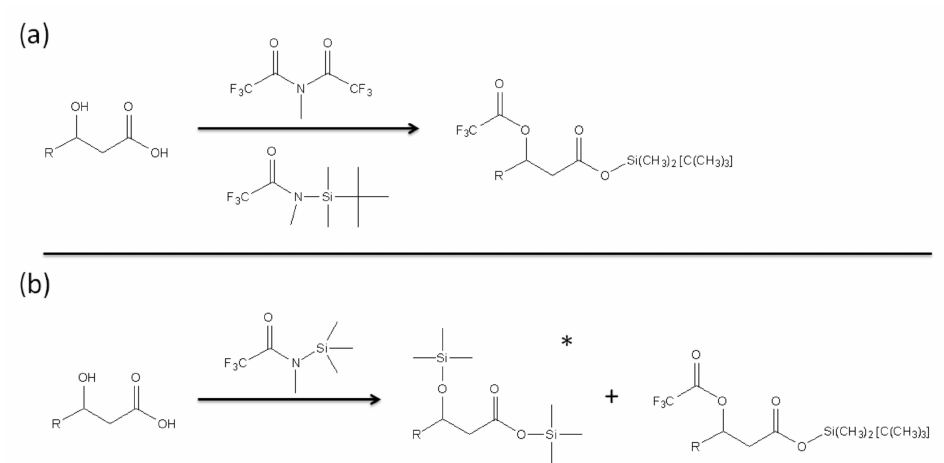
Figure 3. Derivatization of hydroxyl fatty acid using ( a ) methy-bis(trifluoracetamide) (MBTFA) and N- metyhl-N-(tert-butyldimethylsilyl) trifluoracetamide (MTBSTA) and ( b ) N-Methyl-N-(trimethylsilyl) trifluoroacetamide (MSTFA) as derivatizing agents. The * symbol in ( b ) indicates the major product of the derivatization